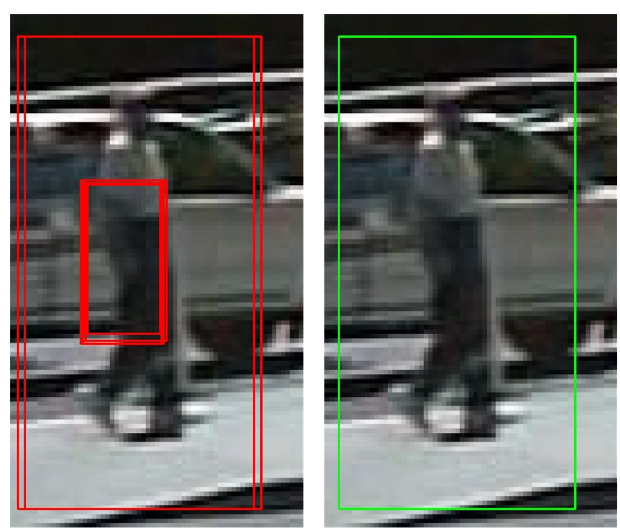
Figure 7. Results without non-maximum suppression ( left ) and with non-maximum suppression ( right